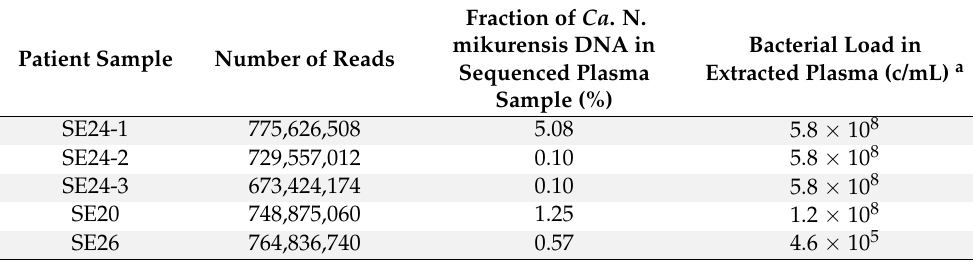
Table 1. Library statistics of Ca . N. mikurensis isolates sequenced from the blood plasma of three neoehrlichiosis patients (SE24, SE20, SE26).